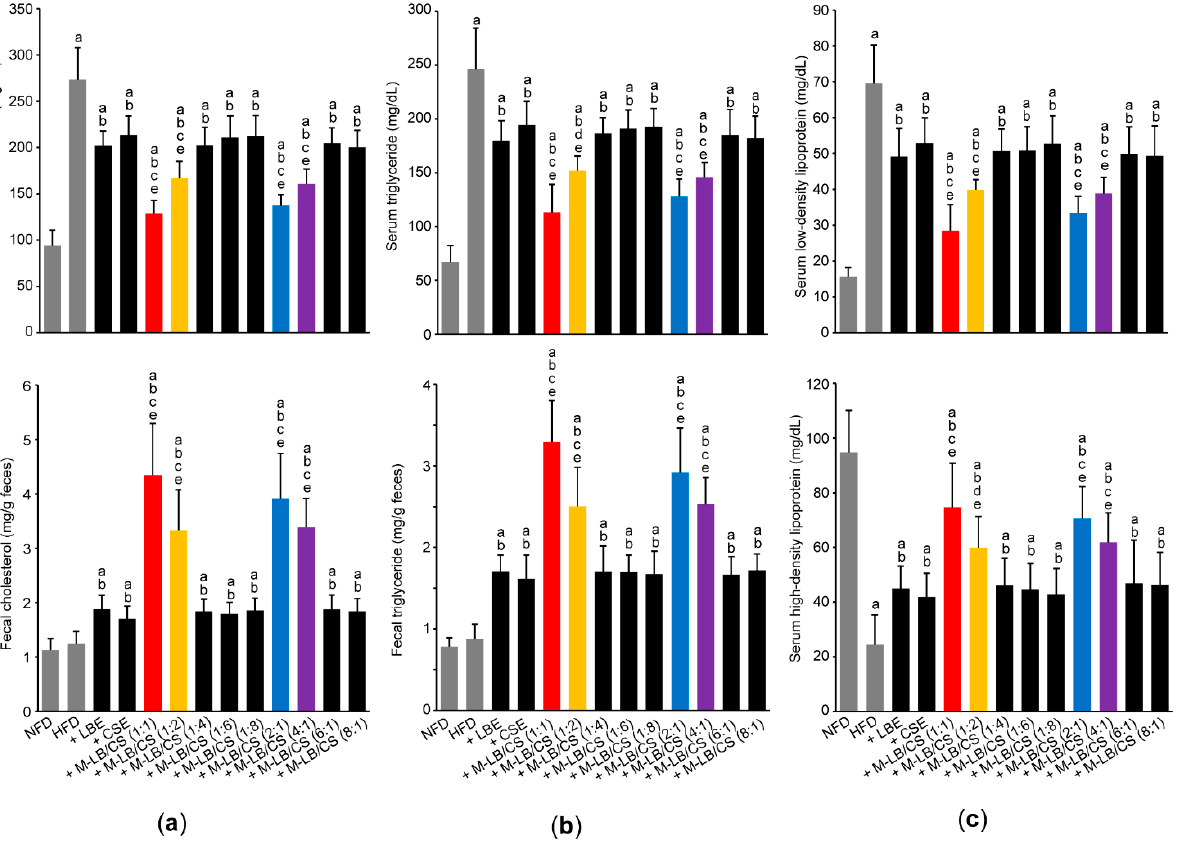
Figure 5. M-LB/CS prevents impaired lipid profiles. Serum ( upper ) and fecal ( lower ) cholesterol ( a ), serum and fecal triglycerides ( b ), and serum low- and high-density lipoprotein ( c ) were determined. a p < 0.01, vs. NFD; b p < 0.01, vs. HFD; c p < 0.01, d p < 0.05, vs. HFD + LBE; e p < 0.01, vs. HFD + CSE.